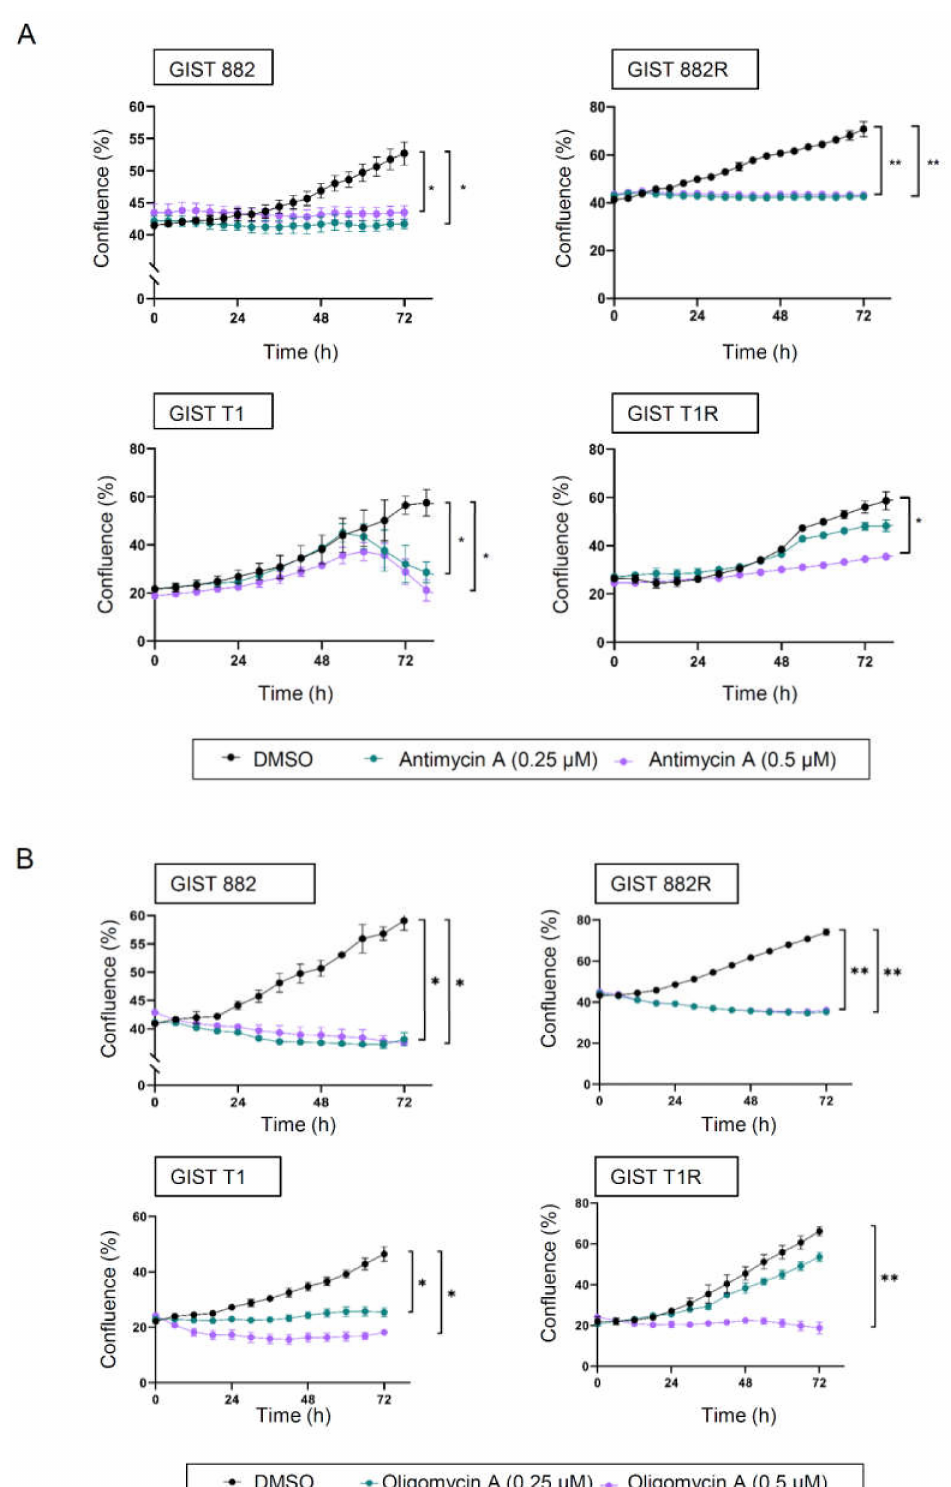
Figure 6. The e ff ect of antimycin A and oligomycin A on GIST cell proliferation. ( A , B ) The cell confluence (% of occupied area) was measured every 6 h using an Incucyte S3 Live Cell Analysis System. GIST cells were treated with antimycin A ( A ) or oligomycin A ( B ) at 0.25 µ M and 0.5 µ M or DMSO. * p < 0.05, ** p < 0.01 (2-way ANOVA, Dunnett’s test, n =